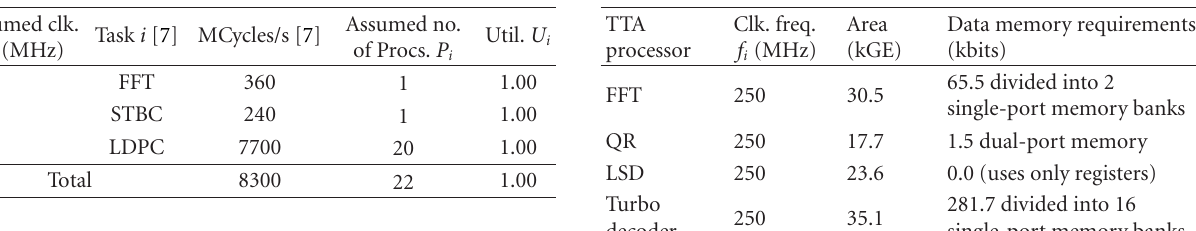
Table 5: Area of the core processor without memories and data memory requirements of the processors.